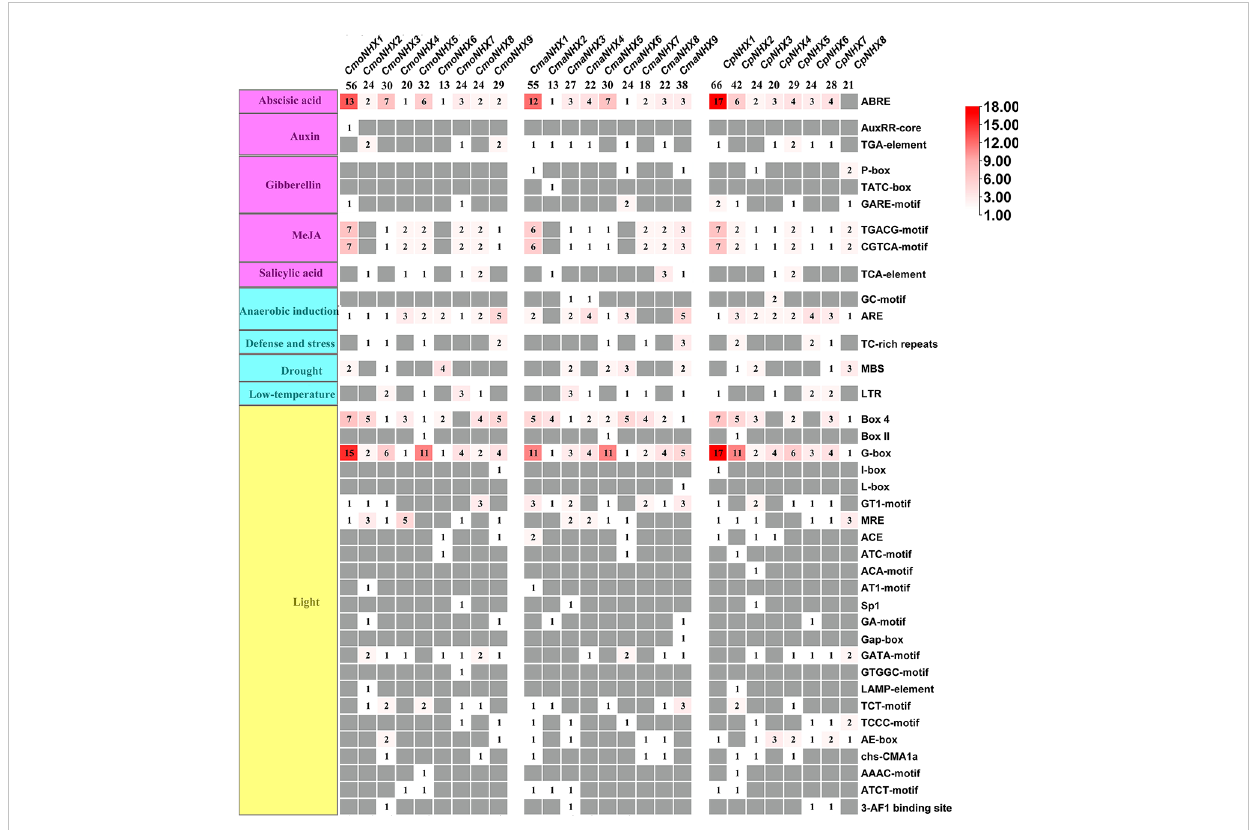
FIGURE 5 Analysis of promoter cis -acting elements of 26 NHX genes in Cucurbita genus. The leftmost side represents the functional distribution of cis -acting elements; the rightmost side represents the name of cis -acting